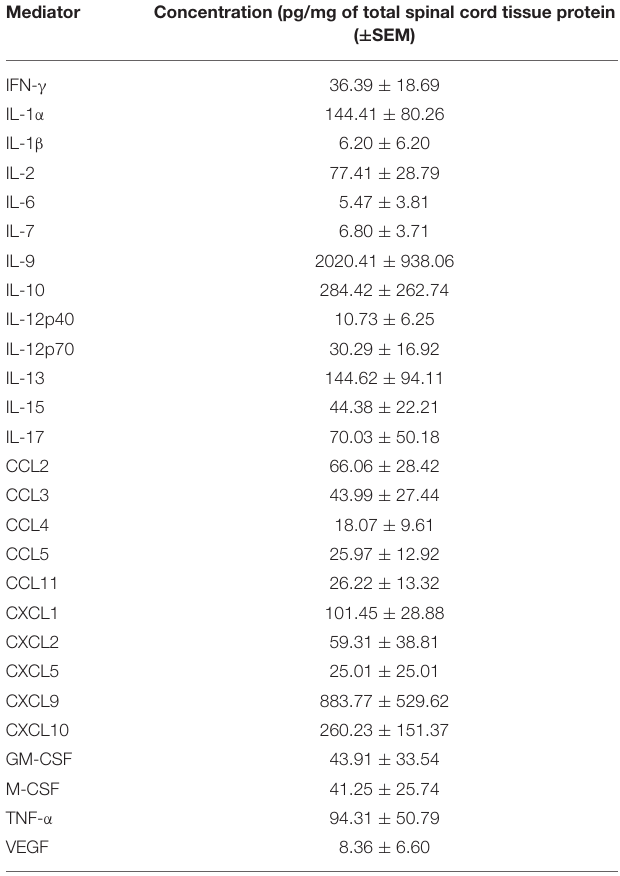
TABLE 1 | Concentrations of various inflammatory mediators in the spinal cords of mice at peak EAE ( n = 3